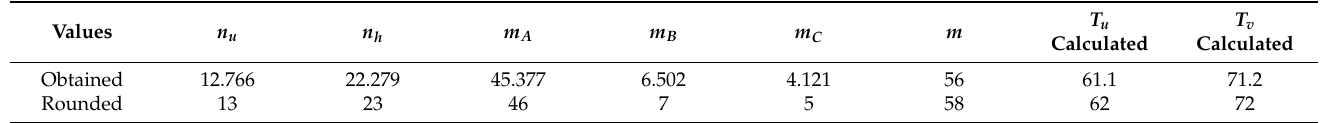
Table 6. Results of applying the formulas to the warehouse of the Kupfer company with area